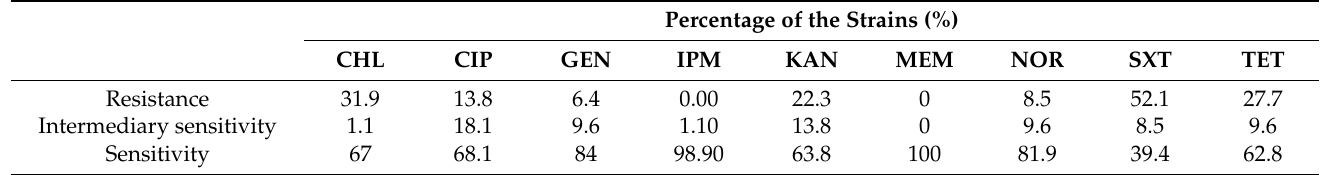
Table 3. The resistance of the 94 K. pneumoniae strains to the nine